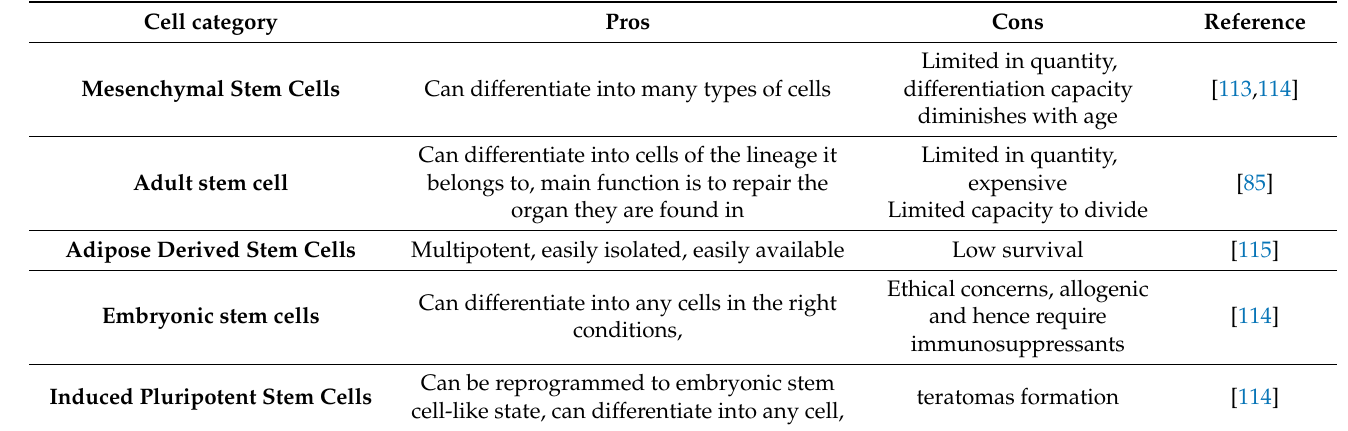
Table 5. Advantages and Disadvantages of the various types of stem cells found within the hu- man body.